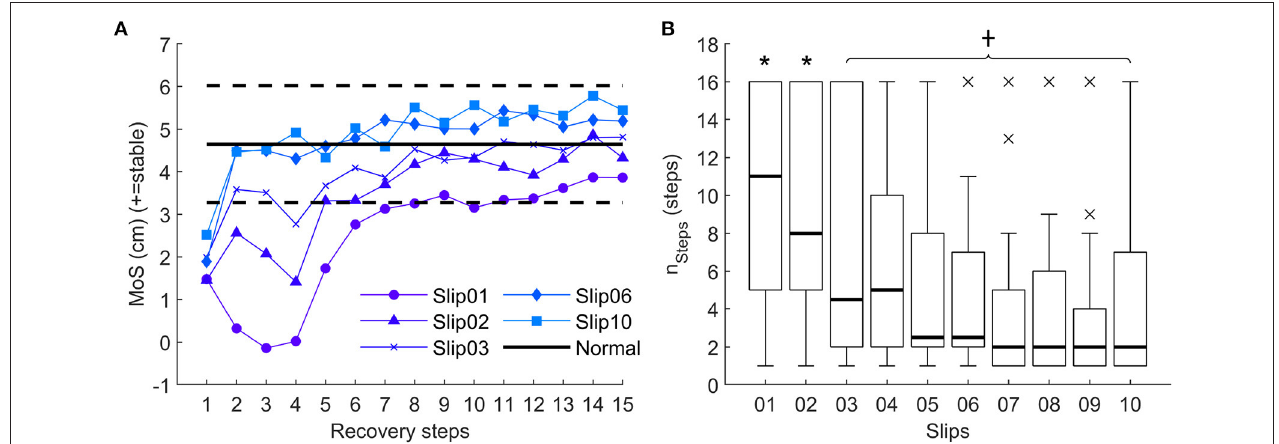
FIGURE 3 | (A) Average margin of stability for all participants for the 15 recovery steps recorded for Slip01, Slip02, Slip03, Slip06, and Slip10. Solid and dotted horizontal black lines represent Normal ± 1 standard deviation (SD), respectively. See Supplementary Figure 2 for YA and OA curves. (B) Boxplots of n steps (i.e. first step of at least three consecutive steps back to ± 1 SD of Normal MoS) from Slip01 and Slip10. Thick horizontal black lines: median; thin horizontal black line: first and third quartiles; × : outliers. *: significantly larger than Slip10, p ≤ 0.0011; †: significantly lower than Slip01, p ≤ 0.0011. See Supplementary Figure 3 for participants’ data